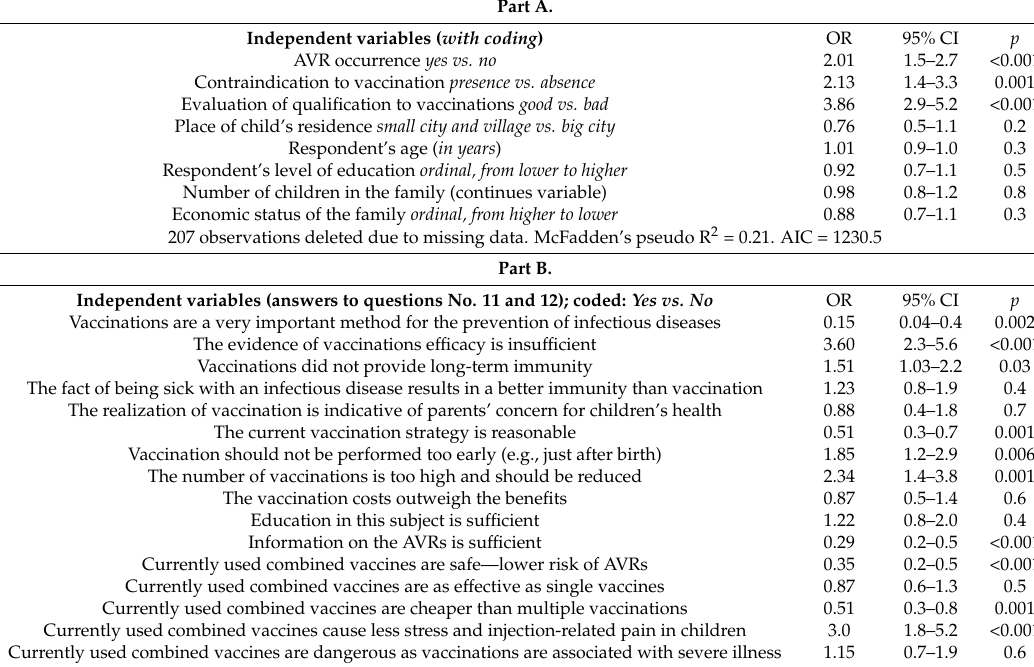
Table 3. Results of multivariable logistic regression (two models: part A and B, respectively) to determine factors associated with parental negative opinion regarding the safety of vaccination in children. Dependent variable: question 10 (safety of vaccinations in children) coded as: No vs. Yes. Part